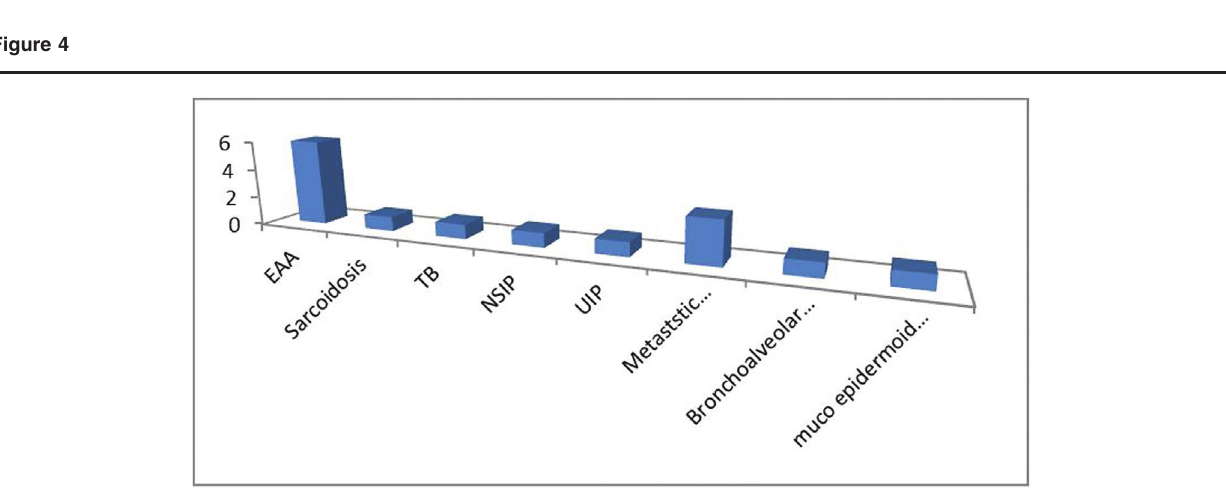
Final diagnosis among the studied